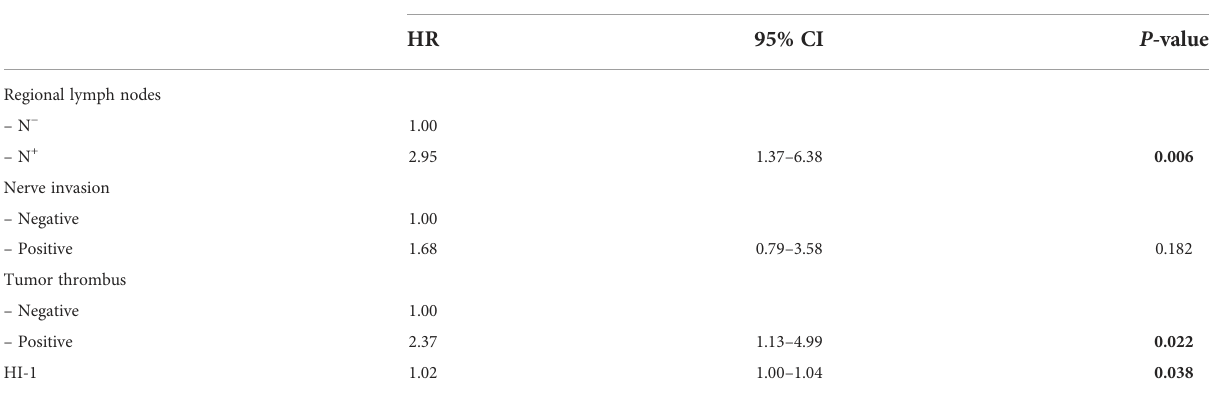
TABLE 6 Multivariate Cox regression analyses for